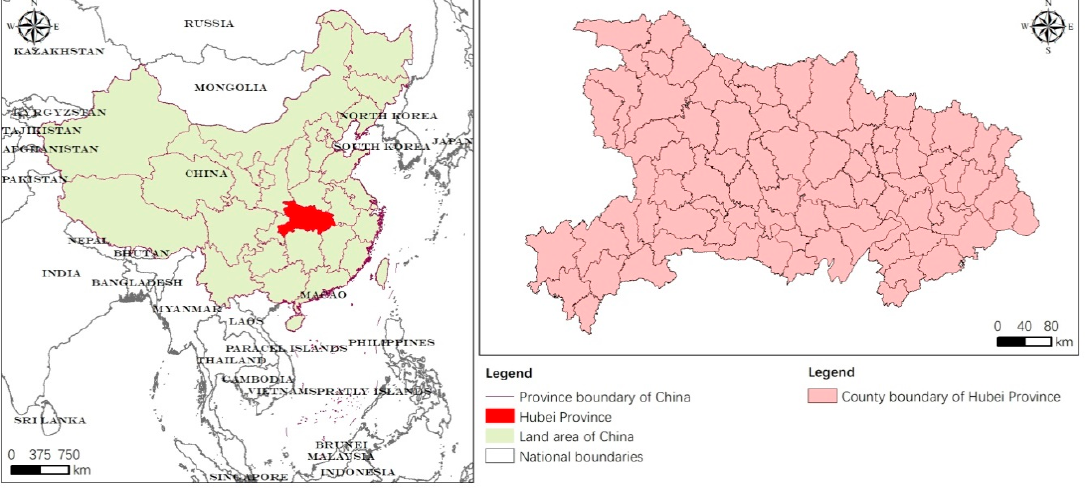
Figure 1. Location of the study area.